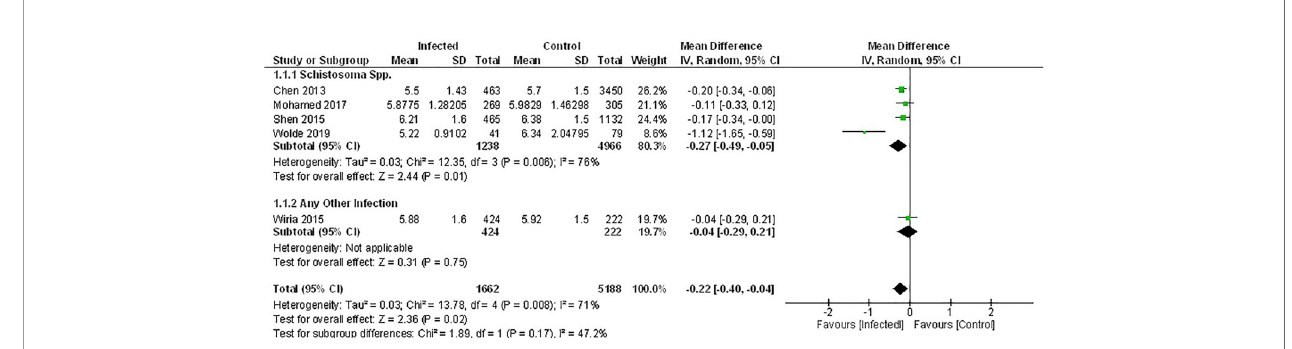
FIGURE 2 | Effect of infection on fasting blood glucose. Forest plot summarising that of the 5 studies included herein, all report lower mean FBG levels in an infected